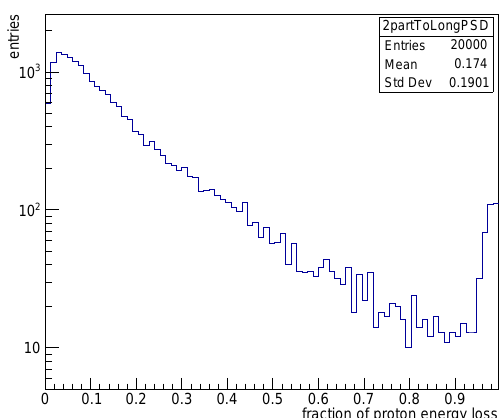
Figure 7. A ratio of deposited energy by a 150 GeV/c proton in the sections from 8 to 20 to the whole long calorimeter PSD (11.2 nuclear int. lengths) in the GEANT4 simulation. The whole calorimeter model has 20 sections. This distribution shows the fraction of a proton energy leak from a calorimeter, which has 3.9 nucl. int. lengths or seven sections in case of